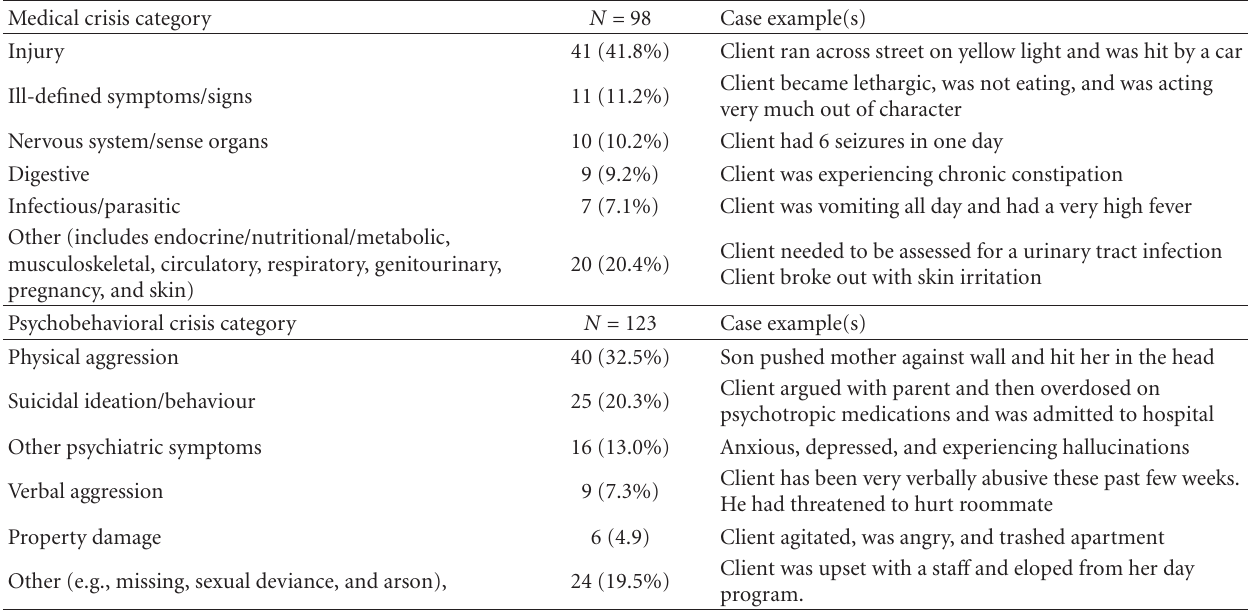
Table 1: Proportion of visits by medical or psychobehavioral presentation